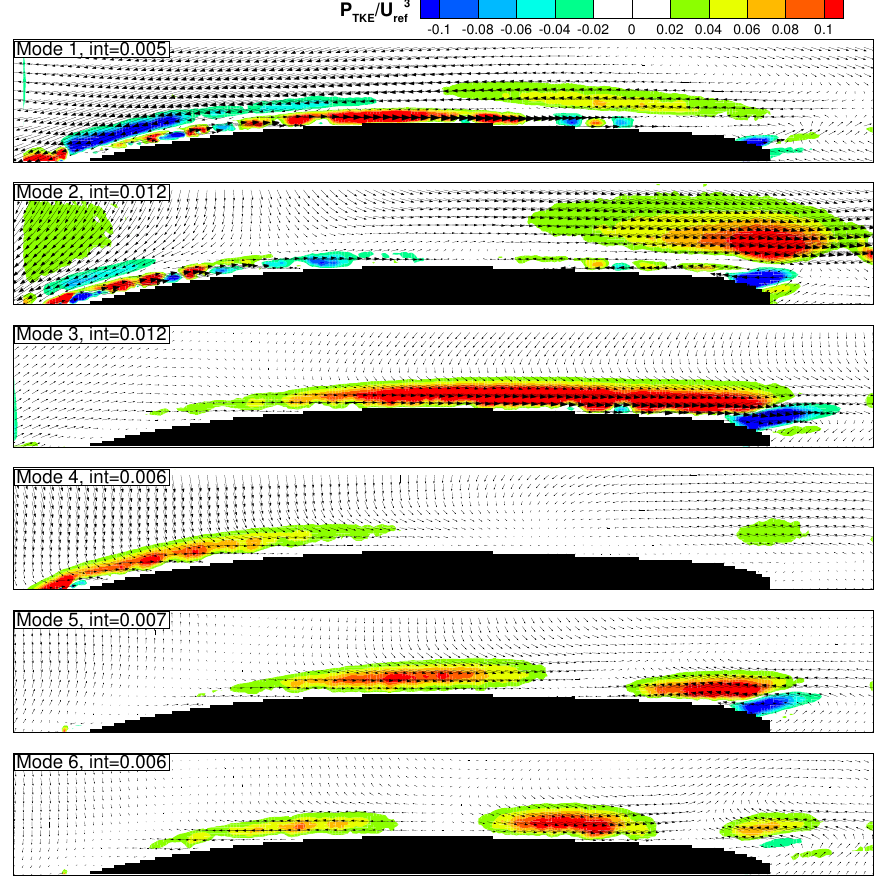
Figure 9. Turbulence kinetic energy production rate per POD mode, nominal f +